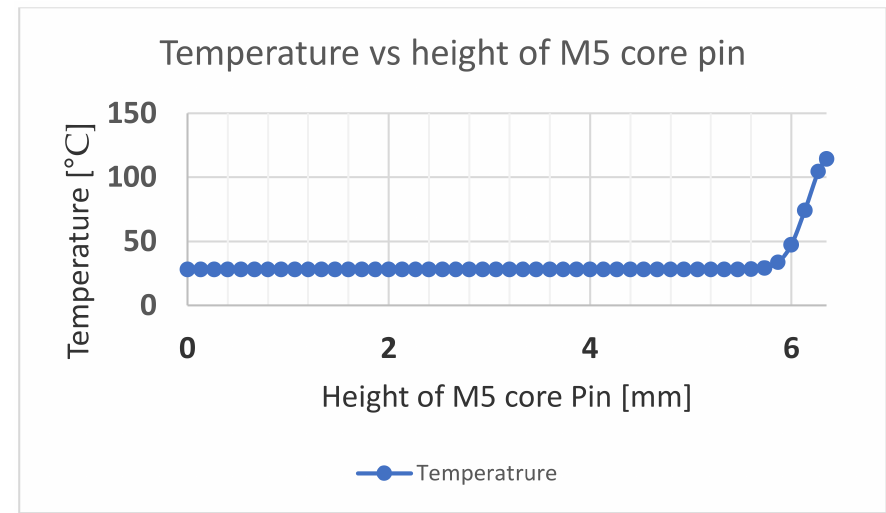
Figure 20. Temperature vs. the height of the core pin measured at a distance of 3.58 mm from the outer surface.